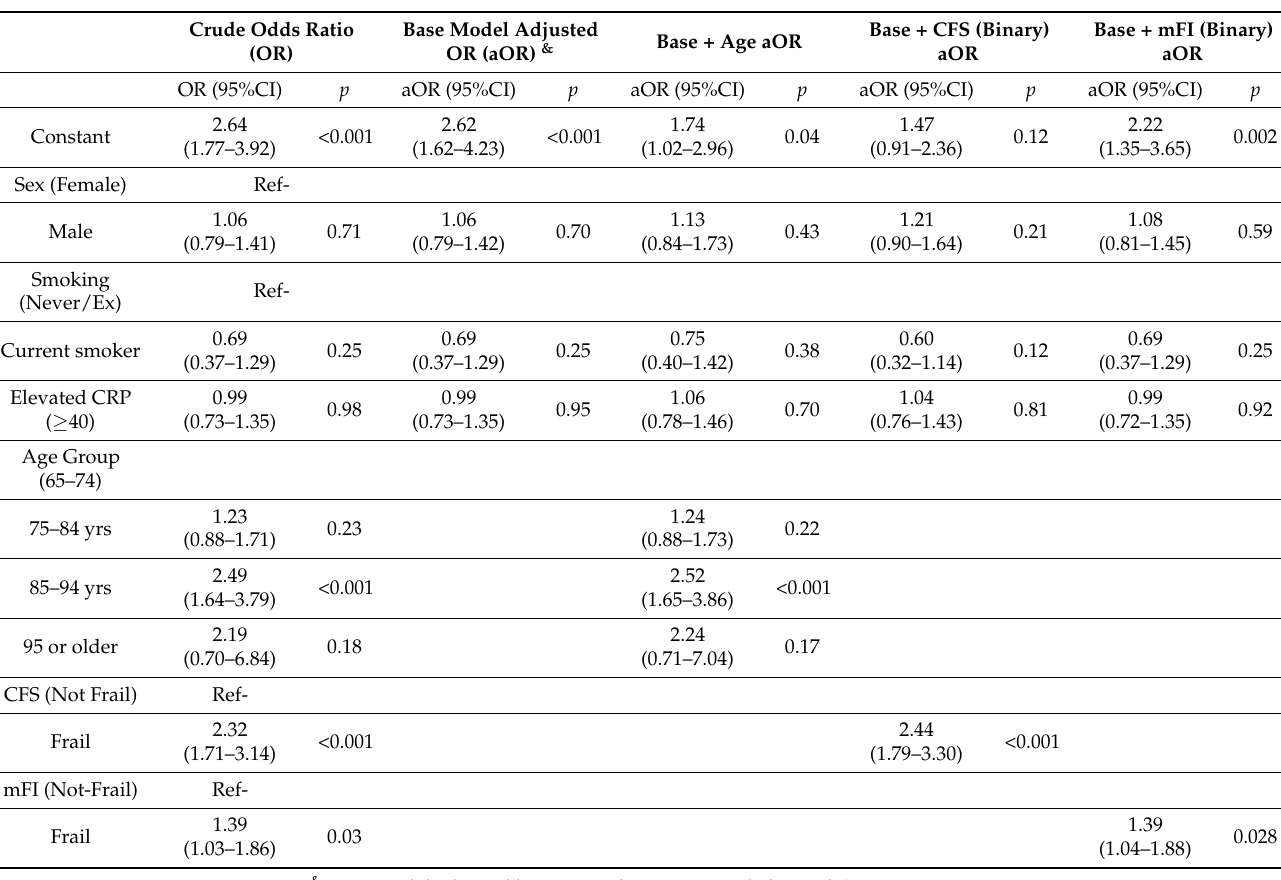
Table 3. Longer Stay, mixed effects logistic regression, presenting the Odds ratio (OR) and adjusted OR (aOR) adjusted for the Clinical Frailty Scale (CFS), modified Frailty Index (mFI), and age